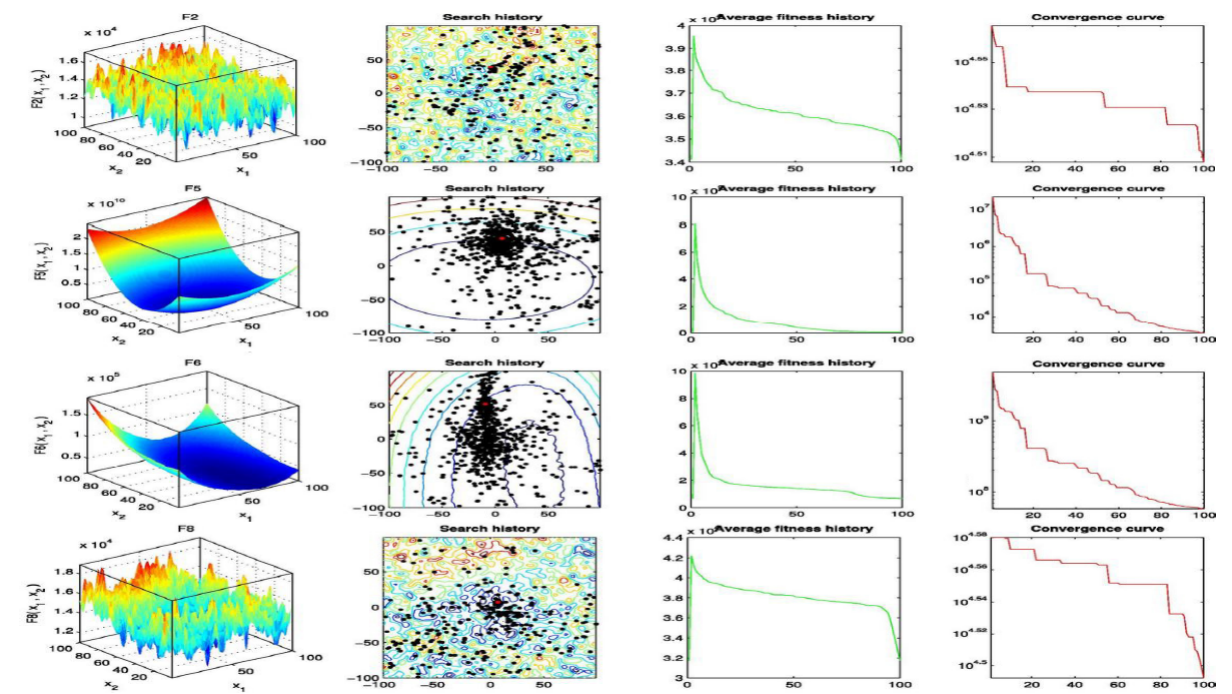
Figure 6. Qualitative metrics on F2, F5, F6, and F8: functions in 2D view, search history, average fitness history, and convergence